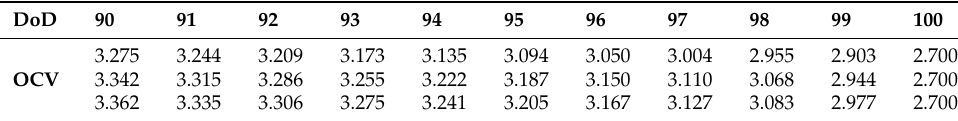
Table A10. OCV models parameters for DoD from 90% to 100%.